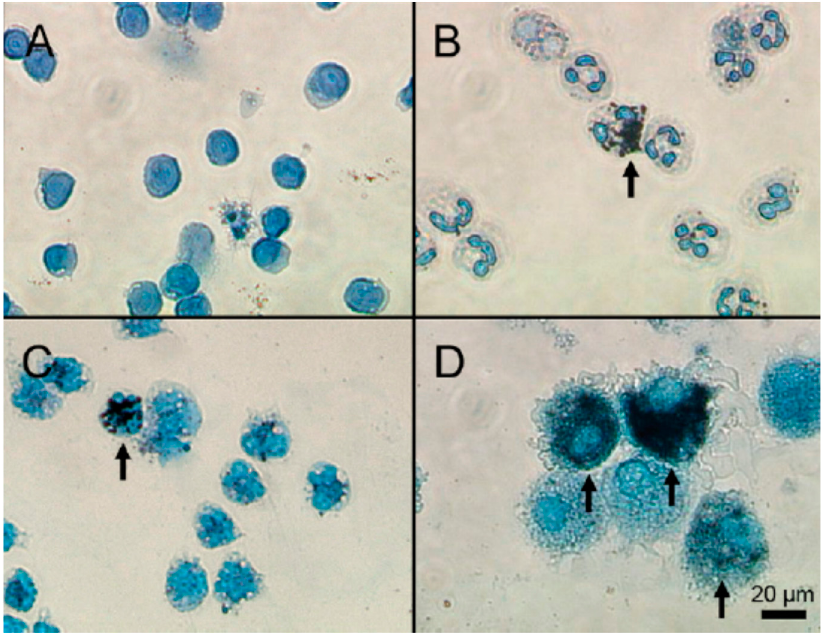
Figure 5. Cytospin preparations of ( A ) lymphocytes; ( B ) neutrophil granulocytes; ( C ) monocytes; and ( D ) macrophages after incubation with CTAB-coated AuNPs. Seedless deposition results in black spots or areas that indicate the presence of gold nanoparticles (indicated with arrows) [78].